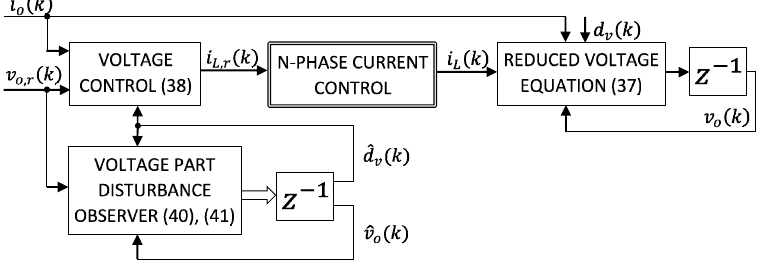
Figure 4. A diagram of voltage control, disturbance observer and N-inner current control loops. Proposed rules to tune the output voltage controller.